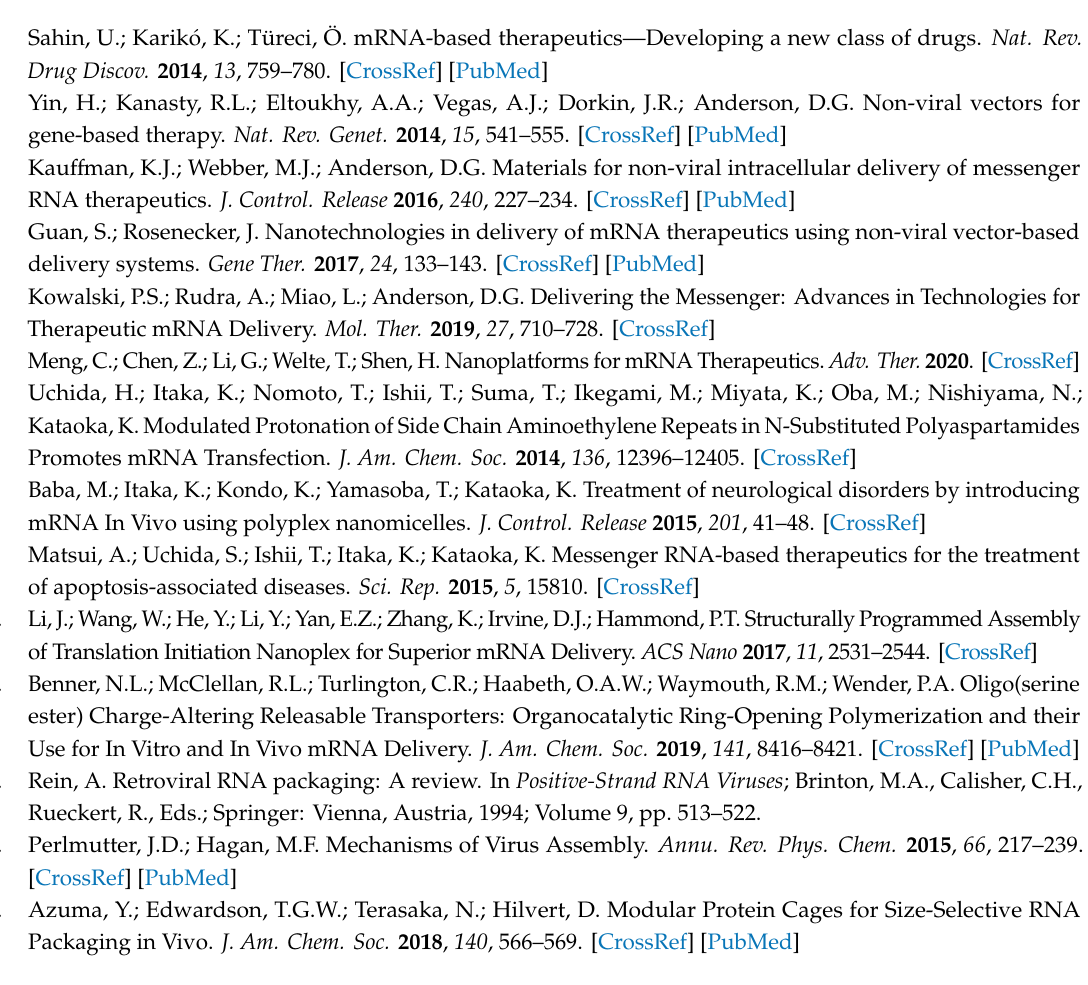
Figure S1: Concentration dependence of size distribution obtained from DLS for the aqueous solution of dT 20 -SS- β -annulus in PBS (pH7.4) at 25 ◦ C, Figure S2: Size-distributions obtained from DLS and TEM images for co-assembly peptides (dT 20 -SS- β -annulus: β -annulus = 1:4.5 (a), 1:2 (b), and 1:1 (c) in water at 25 ◦ C), Figure S3: Gel shift assay obtained after hybridization of co-assembly peptides and mCherry mRNA in PBS (pH 7.4) incubated at various temperatures for 10–30 min, and Figure S4: Size-distributions obtained from DLS and TEM images for co-assembly peptides (dT 20 -SS- β -annulus: β -annulus = 1:9) and mCherry mRNA in PBS bu ff er (pH 7.4) obtained after incubation at 4 ◦ C (a), 37 ◦ C (b), and 60 ◦ C (c) for 10–30